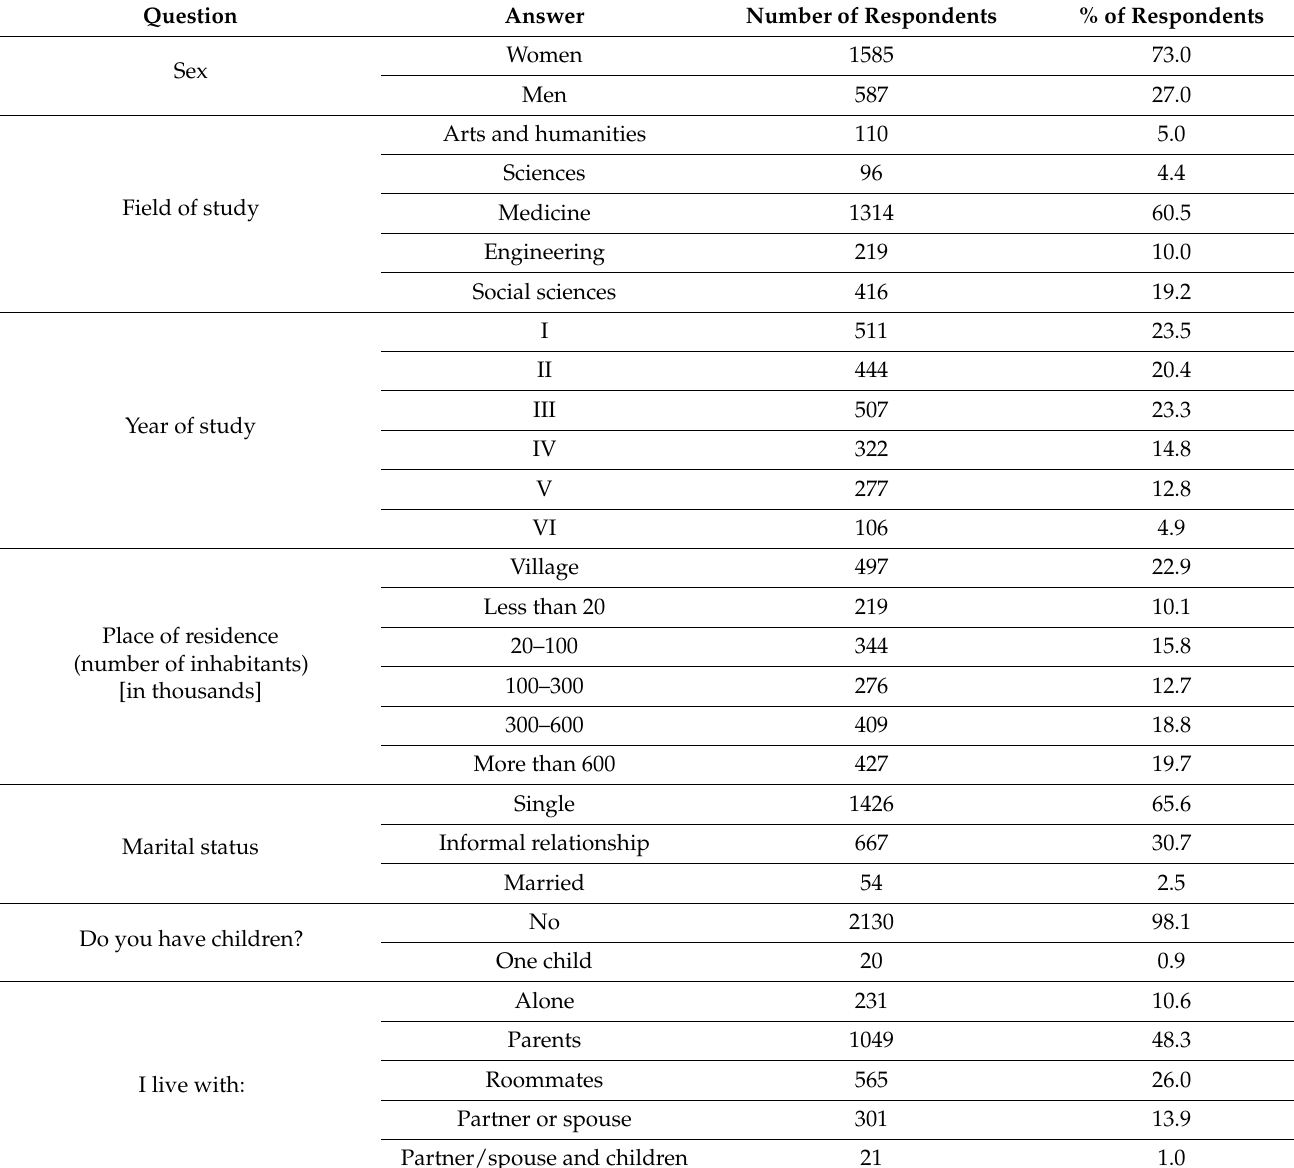
Table 2. Sociodemographic characteristics of the respondents included in the